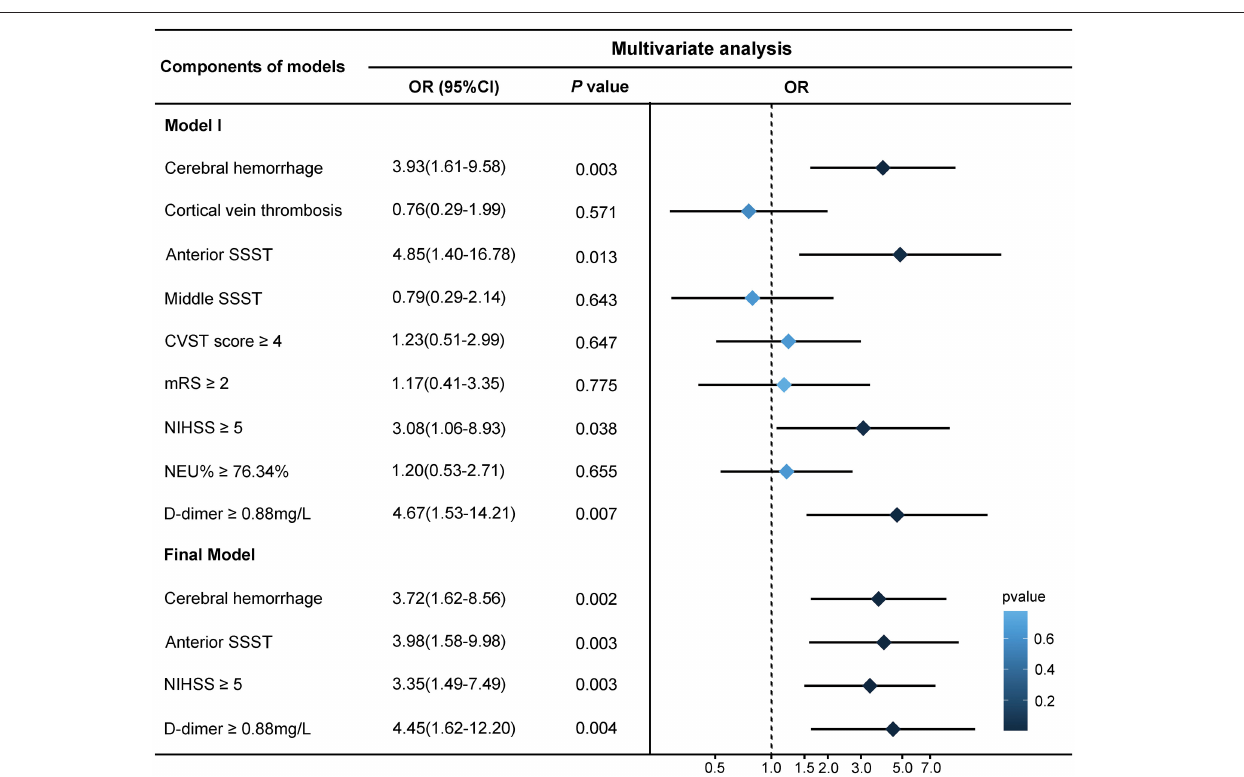
FIGURE 2 | Logistic regression analysis of risk factors for early onset seizures. The cut-off points for factors were calculated on the basis of receiver operating characteristic (ROC) curve analysis. The backward stepwise regression approach was performed to create the final model, in which the least non-significant variable was removed one at a time from the model until all remaining variables were P < 0.05. The forest plot on the right demonstrates the results. SSST, superior sagittal sinus thrombosis; CVST, cerebral venous sinus thrombosis; mRS, modified Rankin Scale; NIHSS, National Institute of Health Stroke Scale; NEU,